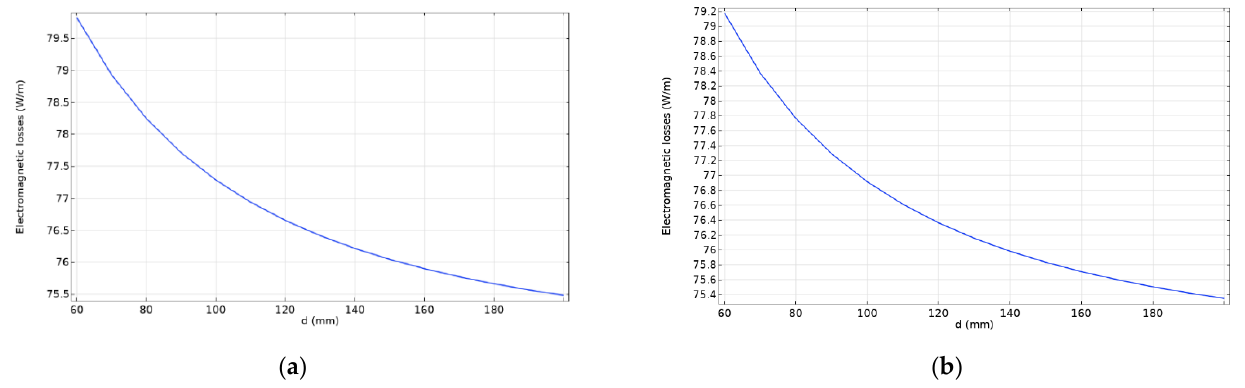
Figure 7. Electromagnetic heating against the phase-to-phase distance at 60 Hz for: ( a ) Model 3; ( b ) Model 4.